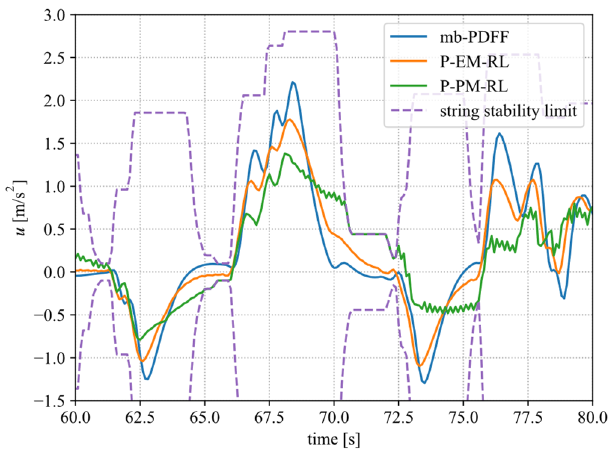
Figure 6. Control value u = u 2, k with respective string-stability limit, created by mb-PDFF, P-EM-RL, and P-PM-RL. The time interval from 60 s to 80 s of the simulation with a total length of 120 s is shown.